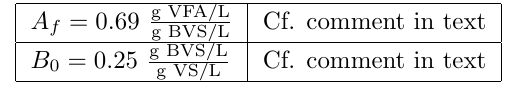
Table 2: Parameters assumed to have known